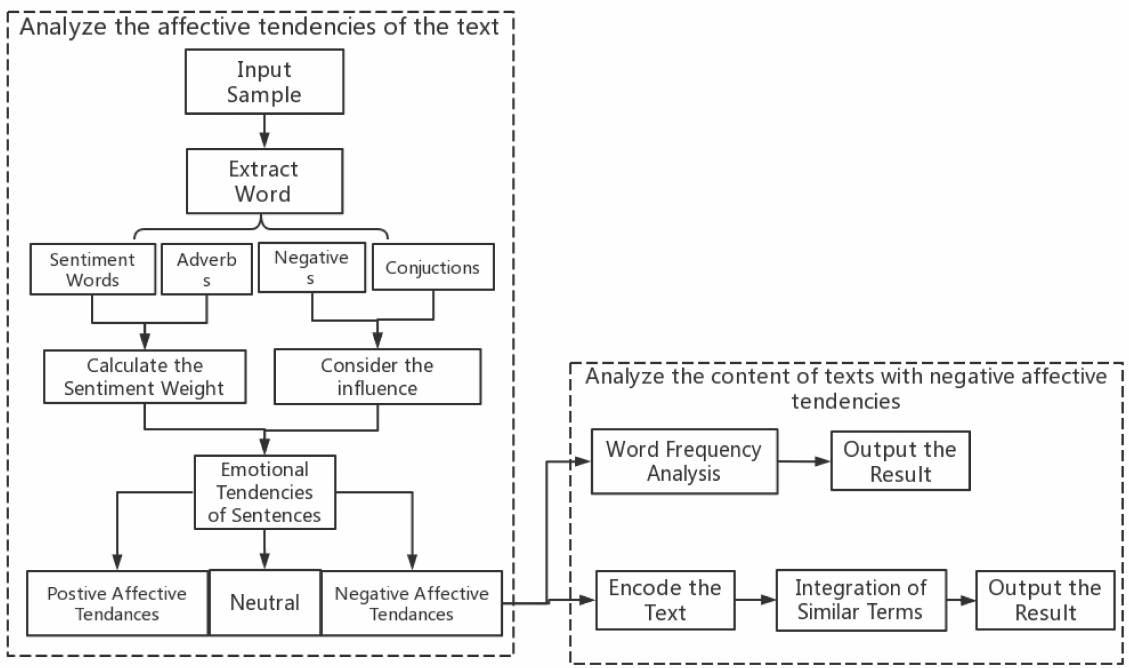
Figure 1. The framework of data